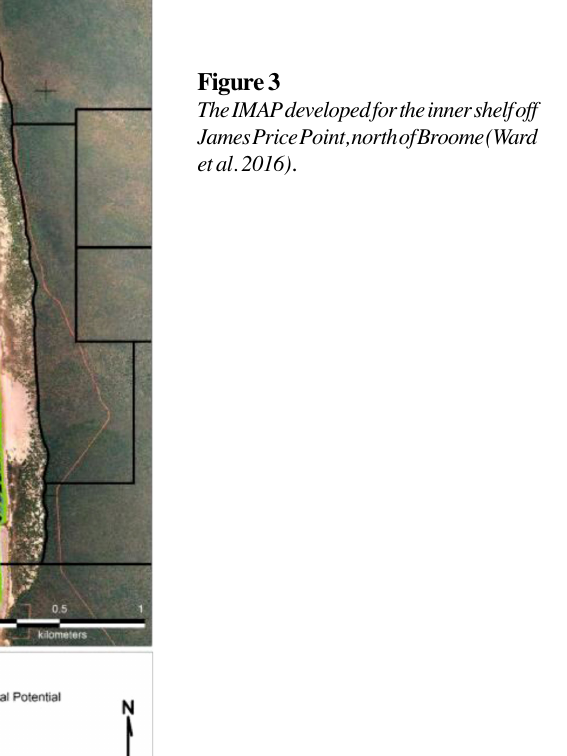
Figure 3 TheIMAPdevelopedfortheinnershelfoff JamesPricePoint,northofBroome(Ward etal.2016)